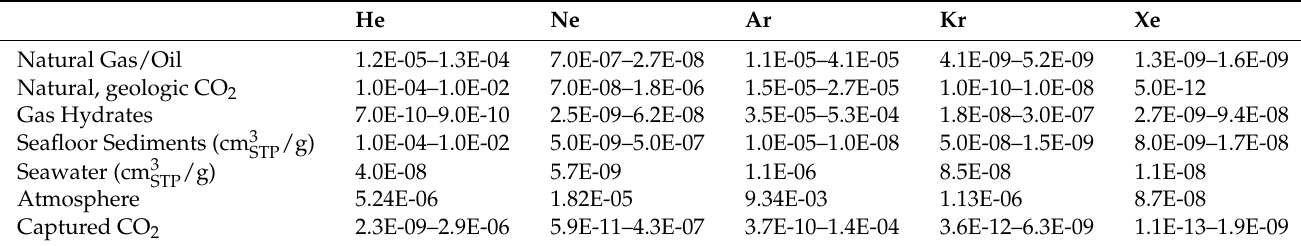
Table 1. Observed noble gas concentrations for different environmental fluids. Natural gas for He, Ne, and Ar compiled from the North Sea Sleipner and Magnus Fields in [28,29], and Kr and Xe from the Sleipner Field [28]. Natural, geologic CO 2 compiled from [30,31]. Sediment values from the South Pacific Ocean [32] and the Mediterranean Ridge for He [33]. Gas hydrates from [34]. Seawater concentrations after [35] (assuming a temperature of 7.5 ◦ C and a salinity of 34.2 g/L). Atmospheric values from [7]. Captured CO 2 from several sites [11–13]. In cm 3 /cm 3 , if not otherwise stated. Rounded STP STP to nearest tenth asides atmosphere. He Ne Ar Kr